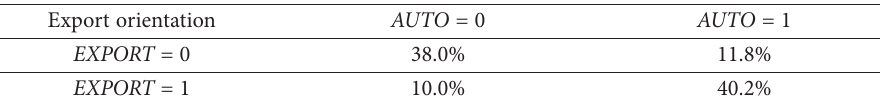
Table 11. Comparison of the model predicting business export orientation from automatically retrieved WWW features to the actual export orientation of the firm Export